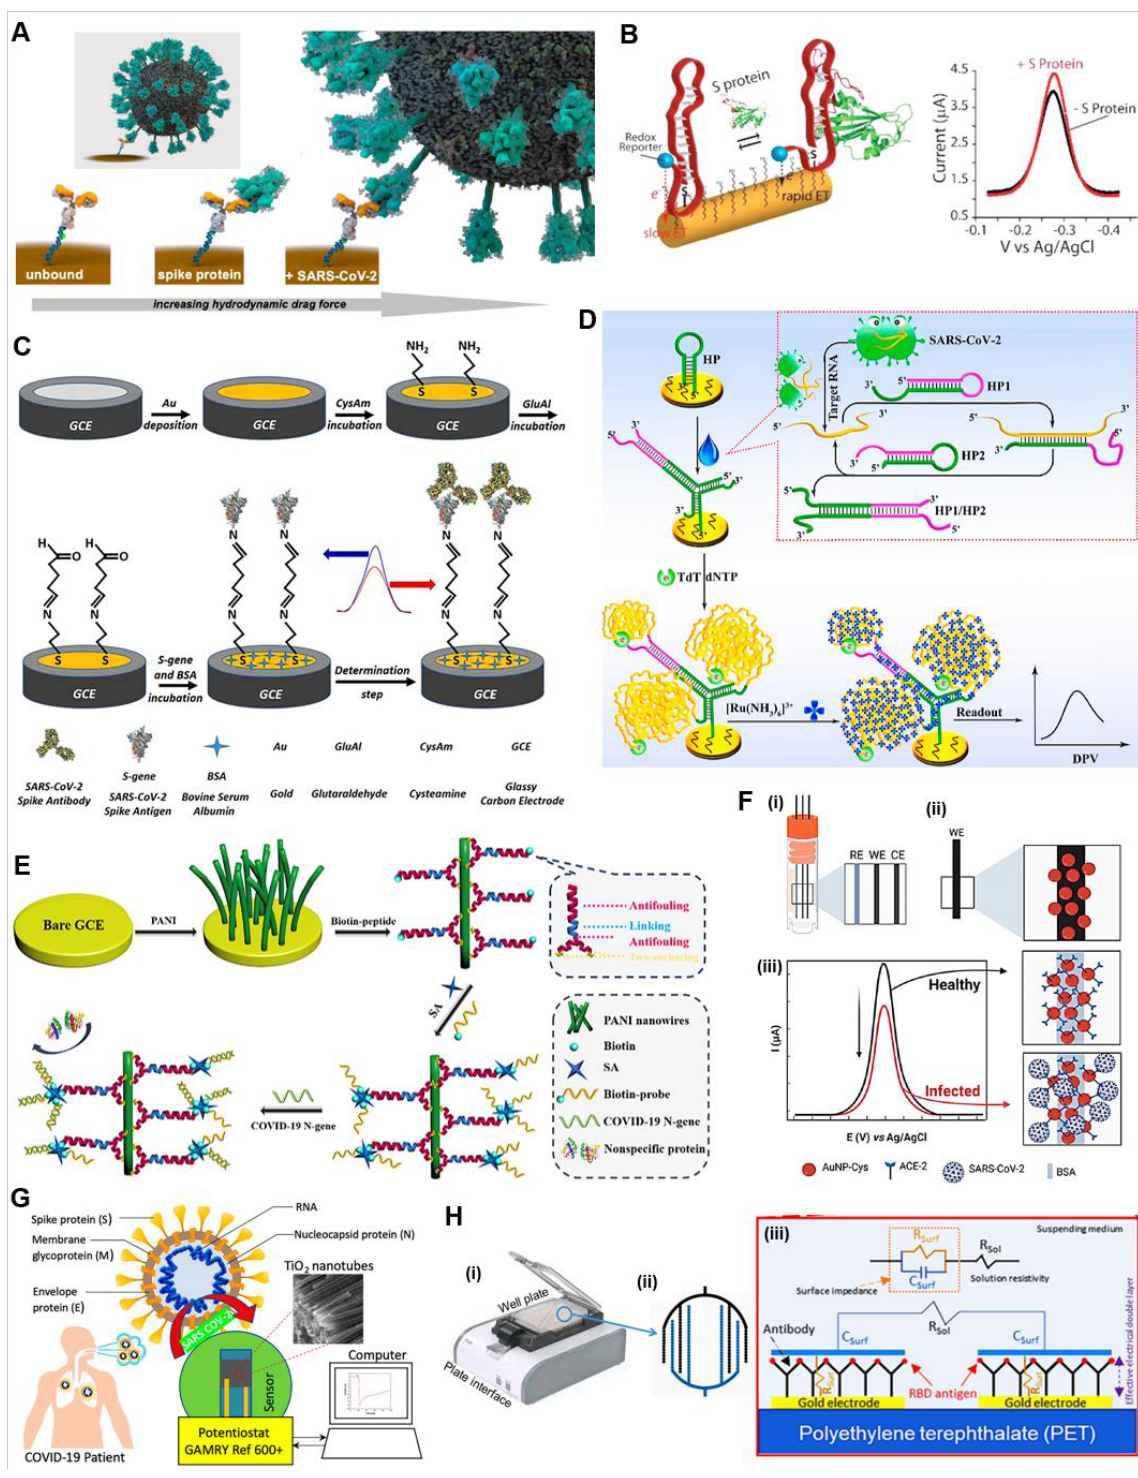
Figure 6. Miscellaneous potential electrochemical assays. ( A ) Schematic of the reagent-free POC electrochemical sensing platform for detection of SARS-CoV-2 viral particles using the molecular pendulum. The sensor undergoes a large change in hydrodynamic diameter when it binds to the spike protein and a viral particle, and then generates signal bending toward the electrode surface as a function of the time to respond. Reproduced with permission from [141]. Copyright 2021, American Chemical Society under ACS COVID-19 subset for unrestricted RESEARCH reuse. ( B ) Schematic of the electrochemical aptamer-based (EAB) sensors employing the binding-induced structural change of a covalently attached and redox reporter (Atto MB2)-modified aptamer that ex-